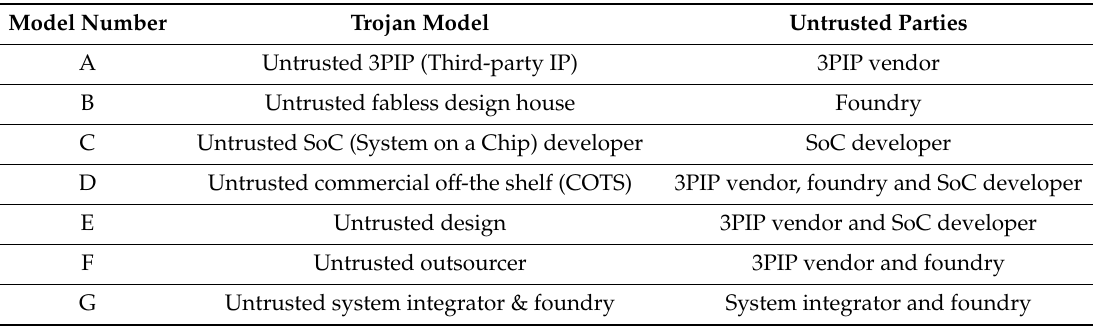
Table 2. Trojan Models based on untrusted